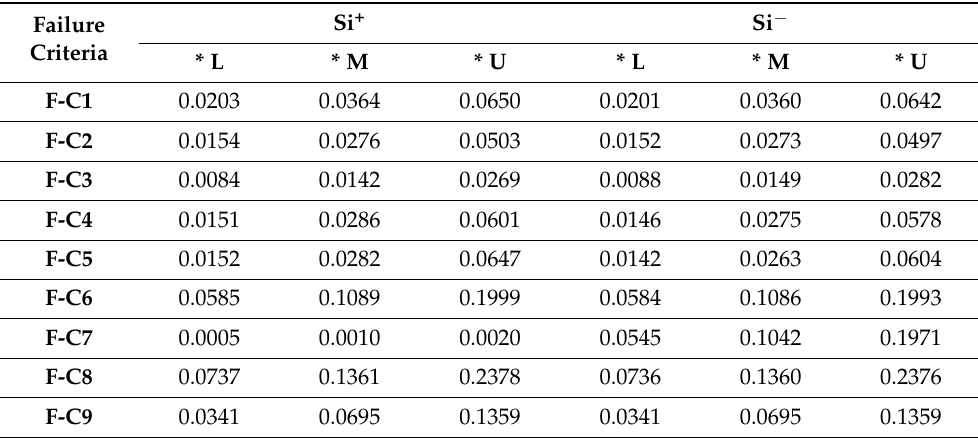
Table 14. FPIS and FNIS values at 50% of cyclic loading